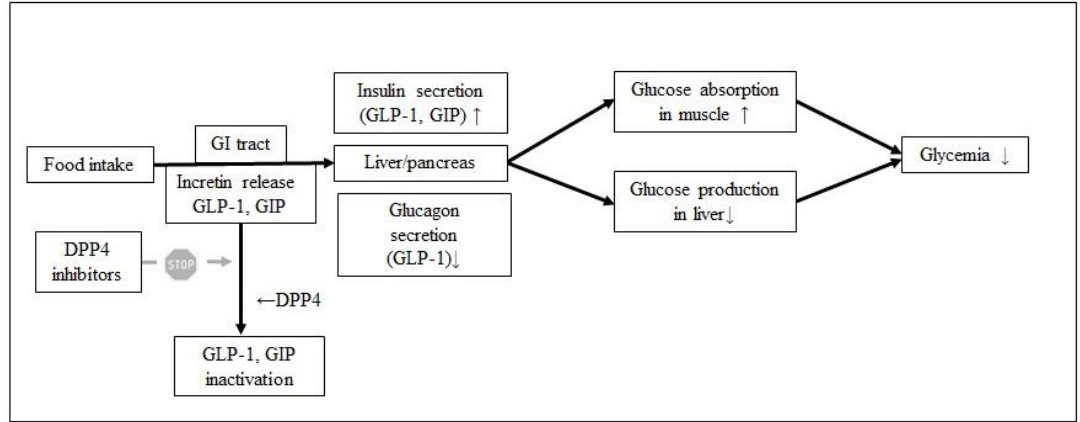
Figure 2. The involvement of the dipeptidyl peptidase IV inhibitors in prolonging the incretin effect according to Mkele [16].